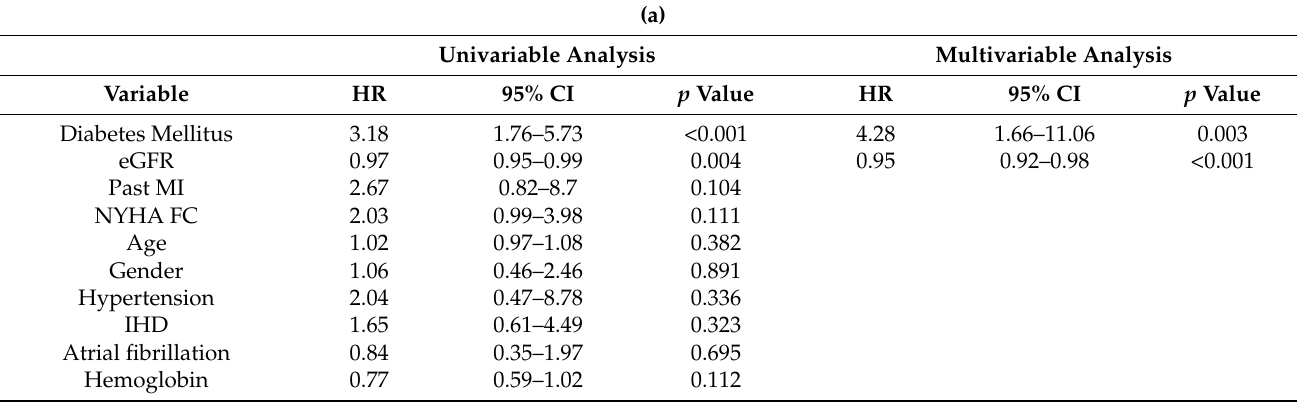
Table 3. ( a ) Univariable and multivariable Cox Proportional Hazards Regression Analysis for the occurrence all cause Death. ( b ) Univariable and multivariable Cox Proportional Hazards Regression Analysis for the occurrence all cause death or heart failure related hospitalization.